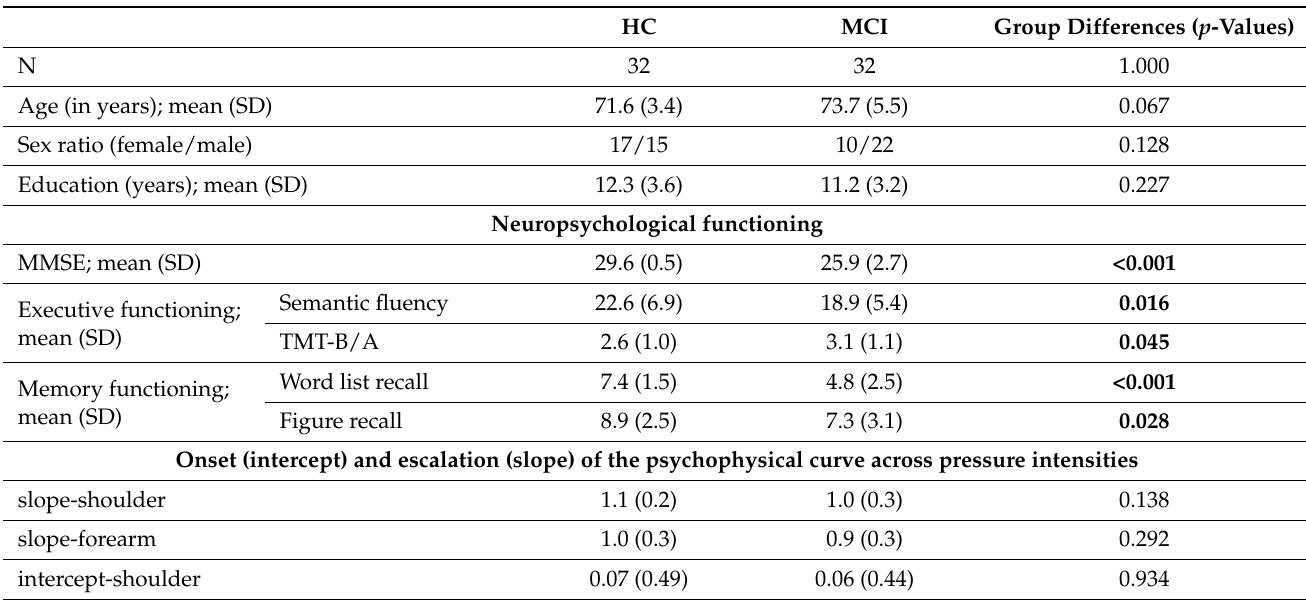
Table 1. Demographic data of the sample studied. HC MCI Group Differences ( p